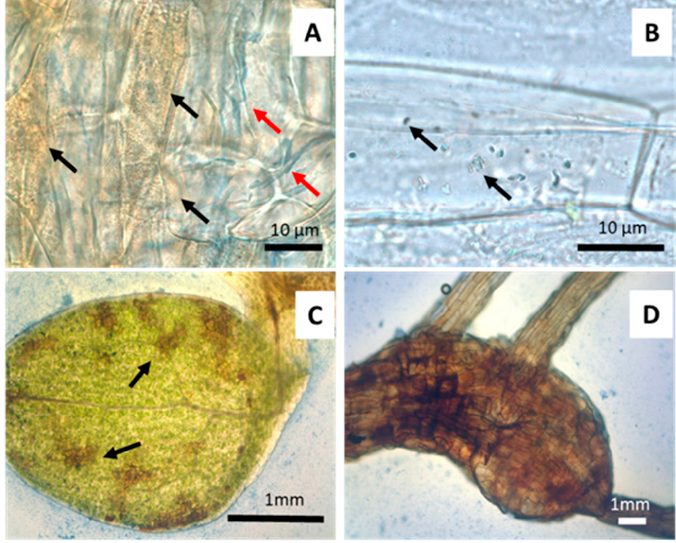
Figure 4. J. montana seedling plants germinated on agarose plates and watered with 1 mM As(V). A . Coccoidal bacteria staining brown on cell wall surface in some root cells (black arrows) with meristemic cells damaged (red arrow). B . Bacteria rods (arrows) with capacity to stain with aniline blue (arrows) inside hypocotylous parenchyma. C . Oxidative deterioration (arrows) in cotyledons with H 2 O 2 accumulation. D . Incipient root tumor caused by arsenic oxidative Figure 4 . J. montana seedling plant control. ( A ). Root surrounded by a bacterium commu ‐ nity (red arrow). ( B ). Detail of the matrix that surrounds the root hairs where aniline blue